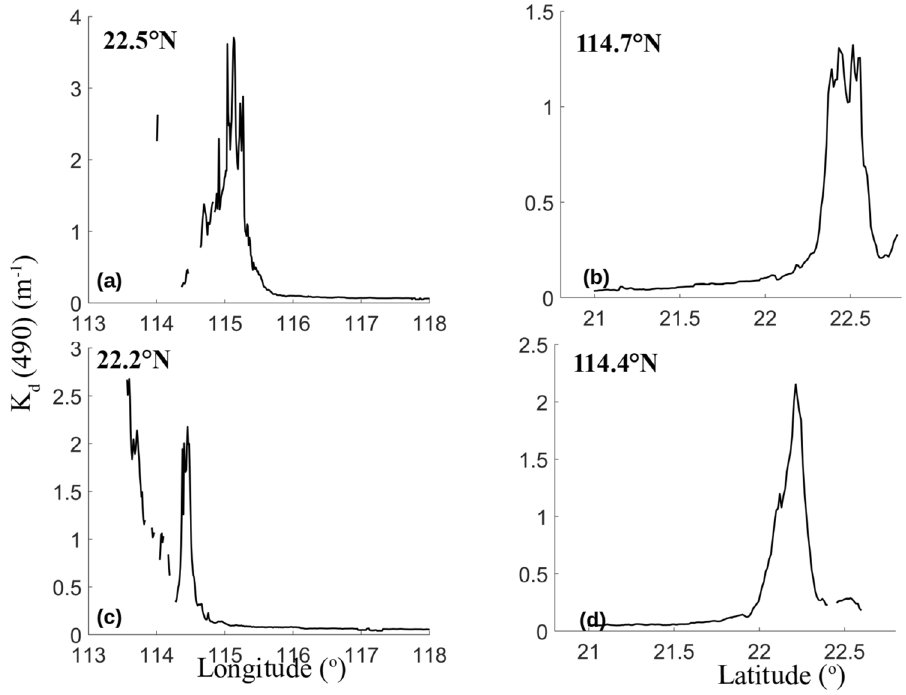
Figure 4. The meridional and zonal distributions of the mean K d (490) values in coastal waters less than 25 m in depth between November and December 2005. Panel ( a ) represents the meridional distribution of the mean K d (490) at 22.5°N; ( b ) represents the zonal distribution of the mean K d (490) at 114.7°E; ( c ) represents the meridional distribution of the mean K d (490) at 22.2°N; and ( d ) represents the zonal distribution of the mean K d (490) at 114.4°E. The program R (version 3.6.3, available at https:// www.r- proje ct. org) was applied for the